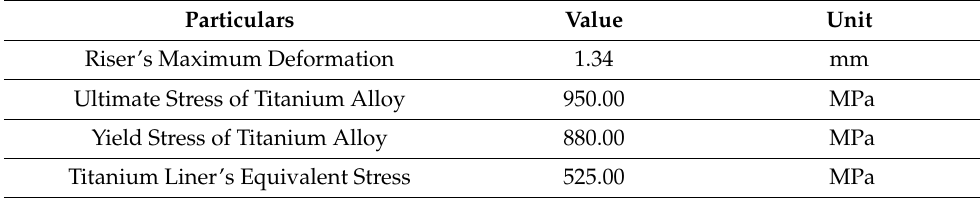
Figure 14. Stress profiles for the top, middle, and bottom lamina along the ( a ) fibre and ( b ) trans- directions under collapse case. verse directions under collapse case. Table 9. Riser deformation and liner stress during collapse event’s preliminary